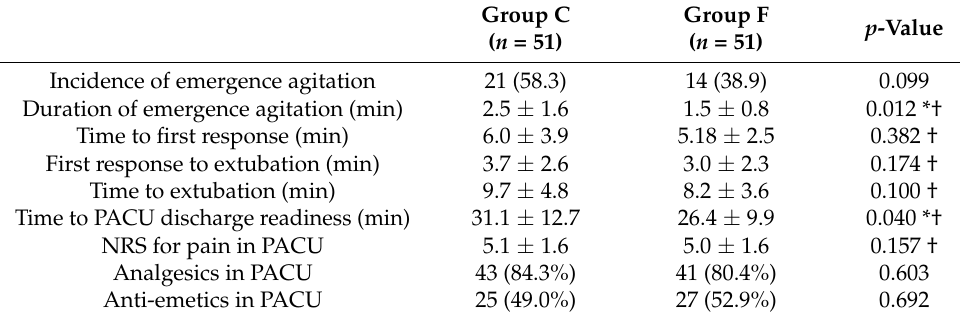
Figure 2. Bar graph showing incidence of emergence agitation (%). The incidence of emergence agitation was 58.3% and 38.9% in groups C and F, respectively. There were no significant differences ( p = 0.099). Group C, control group; Group F, flumazenil group. Table 2. Characteristics of the emergence and recovery